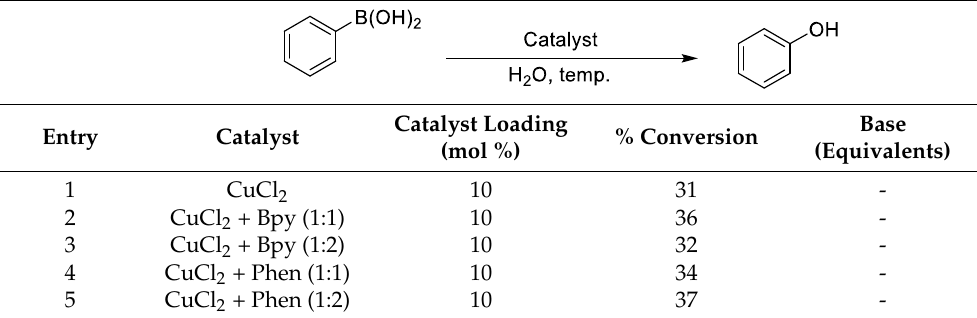
Table 2. Optimization of reaction conditions for some common catalyst systems for the formation of phenol from phenylboronic acid a